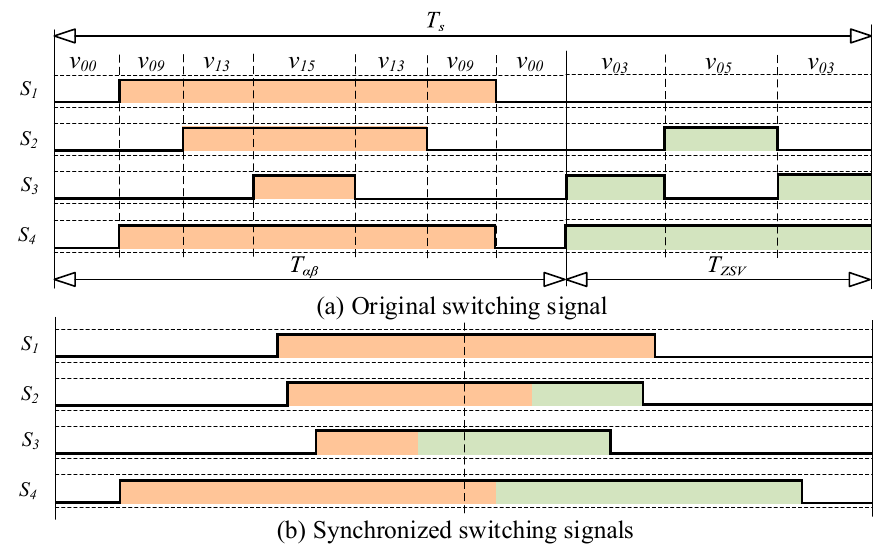
Figure 4. Preselected voltage vectors.